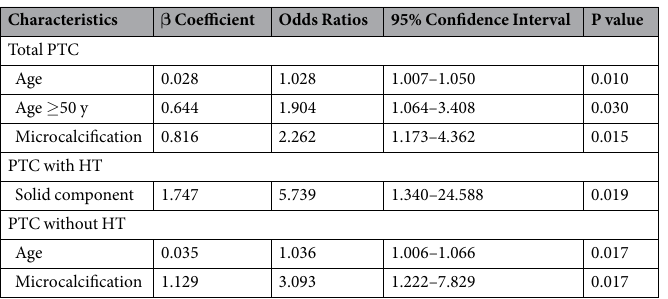
Table 2. Univariate analyses of factors for predicting BRAF mutation. PTC: papillary thyroid carcinoma, HT: Hashimoto’s